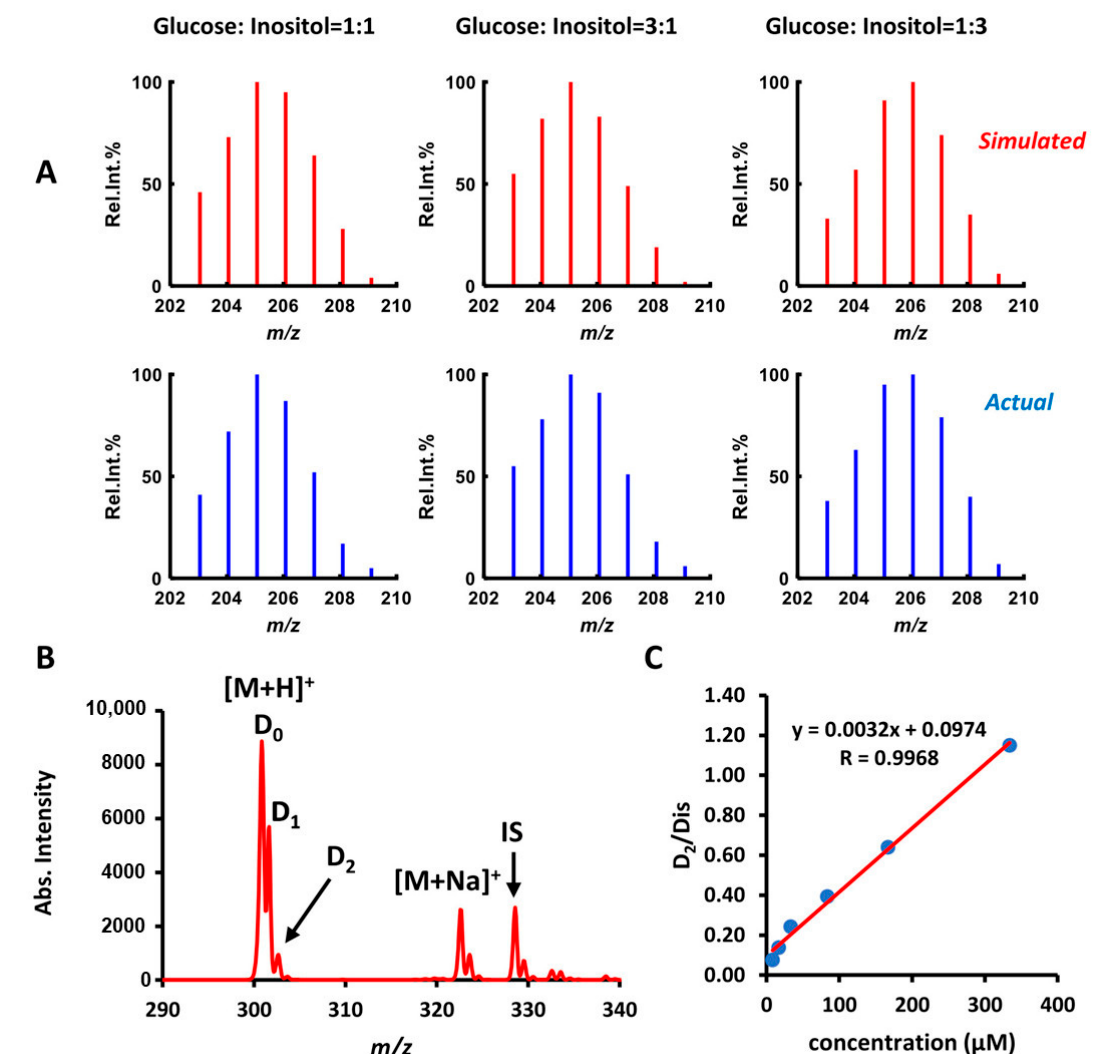
Figure 7. Evaluating the HDX–CPSI-MS in relative and absolute quantitation. ( A ) Simulated and actual HDX mass spectra collected from the mixed solution of glucose and inositol. ( B ) Representative HDX mass spectra of target codeine, and the internal standard (IS, 6-acetyl morphine). The interference compound, hydrocodone, was overlapped with codeine in peaks at m / z 300 (D 0 ), and 301 (D 1 ). However, the deuterium ion at m / z 302 (D 2 ) only belongs to the target and was selected as the signature ion for quantitation; ( C ) Quantitation curve constructed by fitting the IS-calibrated response (D 2 /D is ) versus codeine’s concentration.